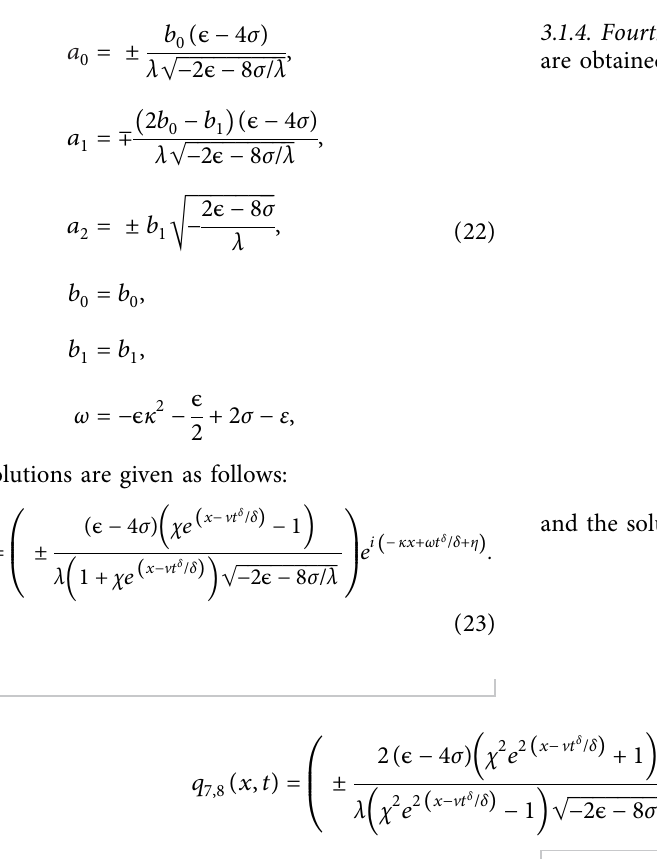
Figure 1: Te plot of the |(25)| for ϵ � 1 , λ � 2 , σ � 4 , κ � − 2 , η � 1 , ε � 2 , χ � 2 , δ � 0 . 1: (a) 3D plot and (b) contour